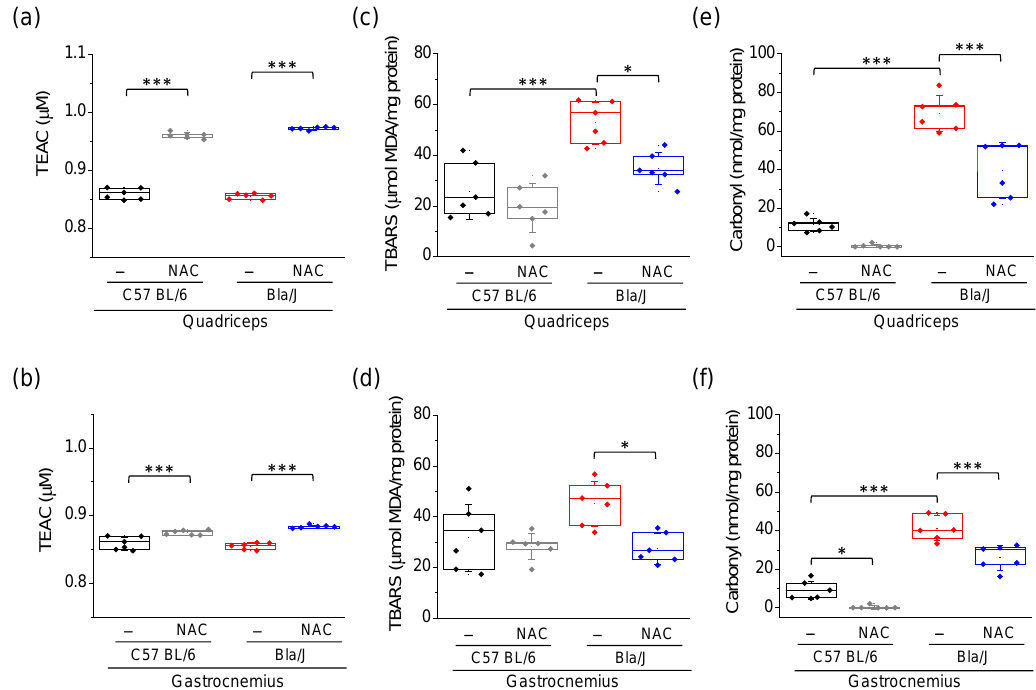
Figure 1. Effects of NAC on Trolox equivalence antioxidant capacity (TEAC), lipid peroxidation and protein carbonyl on quadriceps and gastrocnemius muscles of dysferlin-deficient Bla / J mice. TEAC ( a , b ), thiobarbituric acid reactive substances (TBARS), a lipid peroxidation marker ( c , d ), and protein carbonyl content ( e , f ) were measured in quadriceps (upper panels) and gastrocnemius (lower panels) of C57 BL/6 or Bla/J mice untreated or treated with 1% NAC for 10 weeks. Boxes indicate 25–75 percentiles, lines within boxes indicate medians, and whiskers indicate SD. Each dot represents an individual sample (six mice per group). * p < 0.05; *** p < 0.001 (one-way ANOVA followed by Tukey-Kramer multiple comparisons test). All data pass the Kolmogorov–Smirnov normality test.